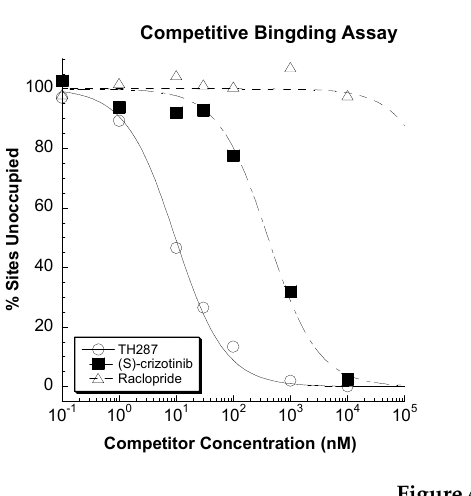
TH287: PseudoHill Plot